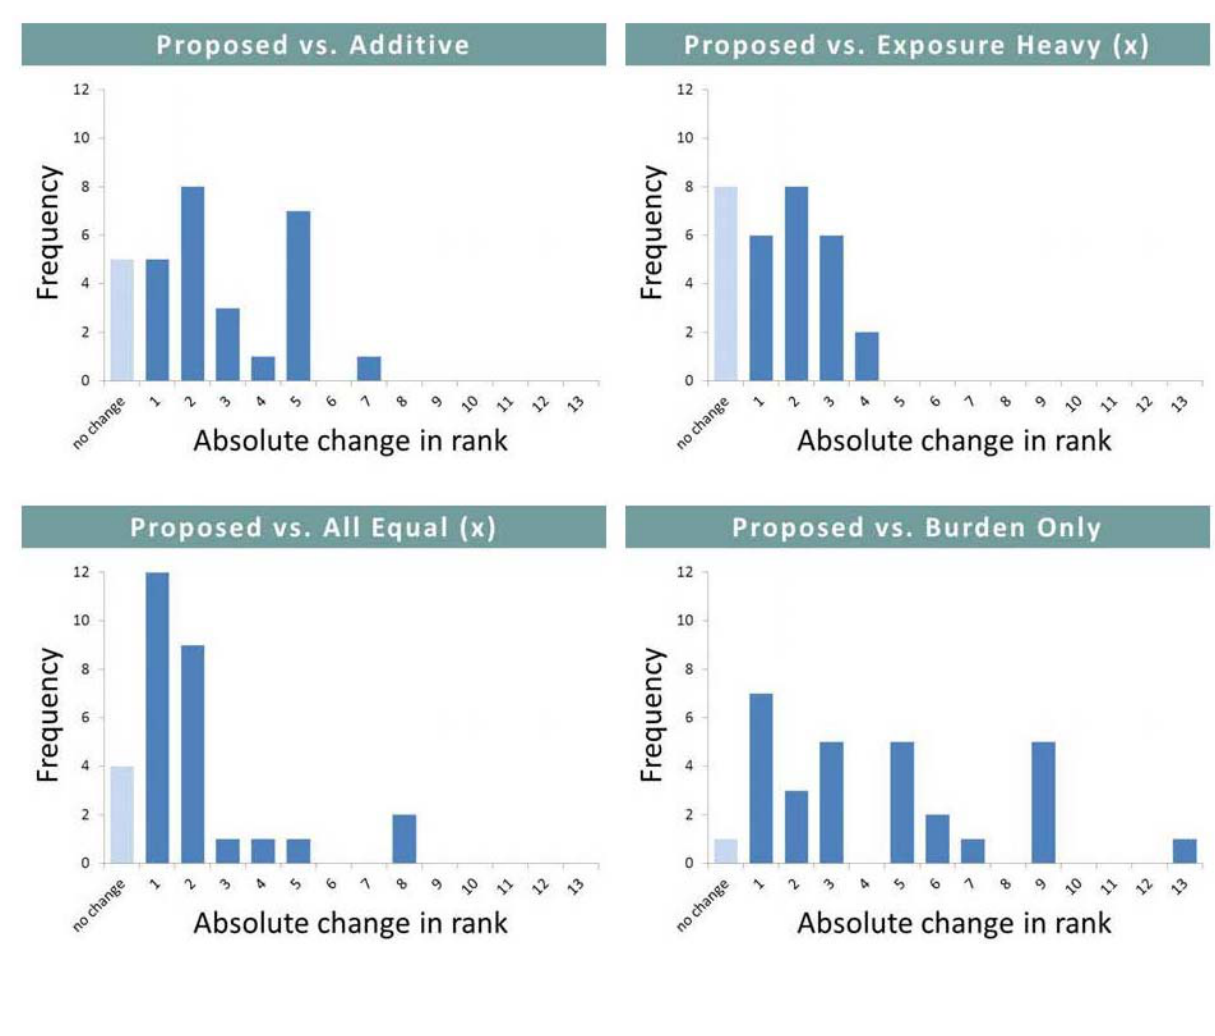
Figure 4. Frequency and magnitude of changes in rank associated with varying the